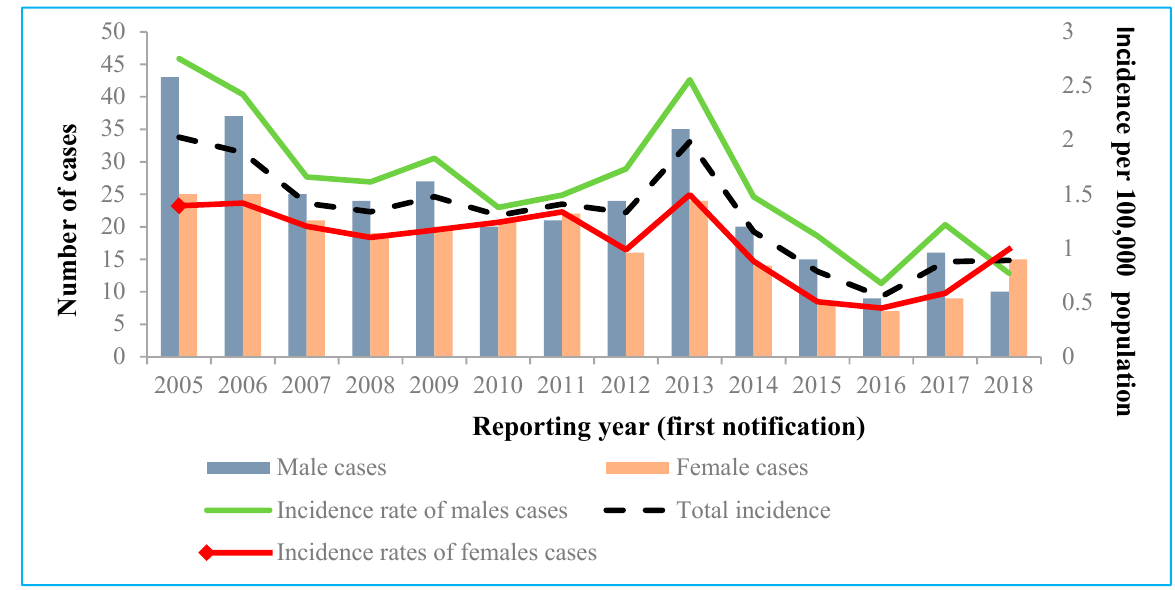
Figure 2. Number and incidence rates of acute hepatitis C virus cases by gender, Lithuania, 2005–2018.